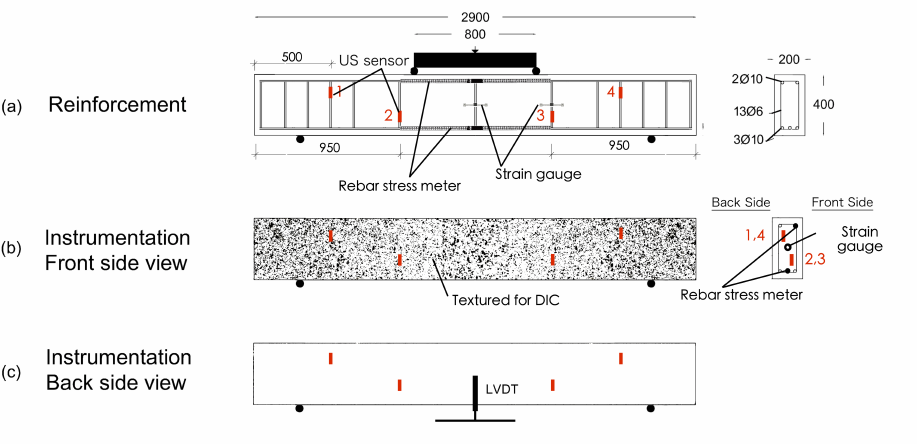
Figure 7. Dimensions of the beam, rebars distribution, and sensors positions at